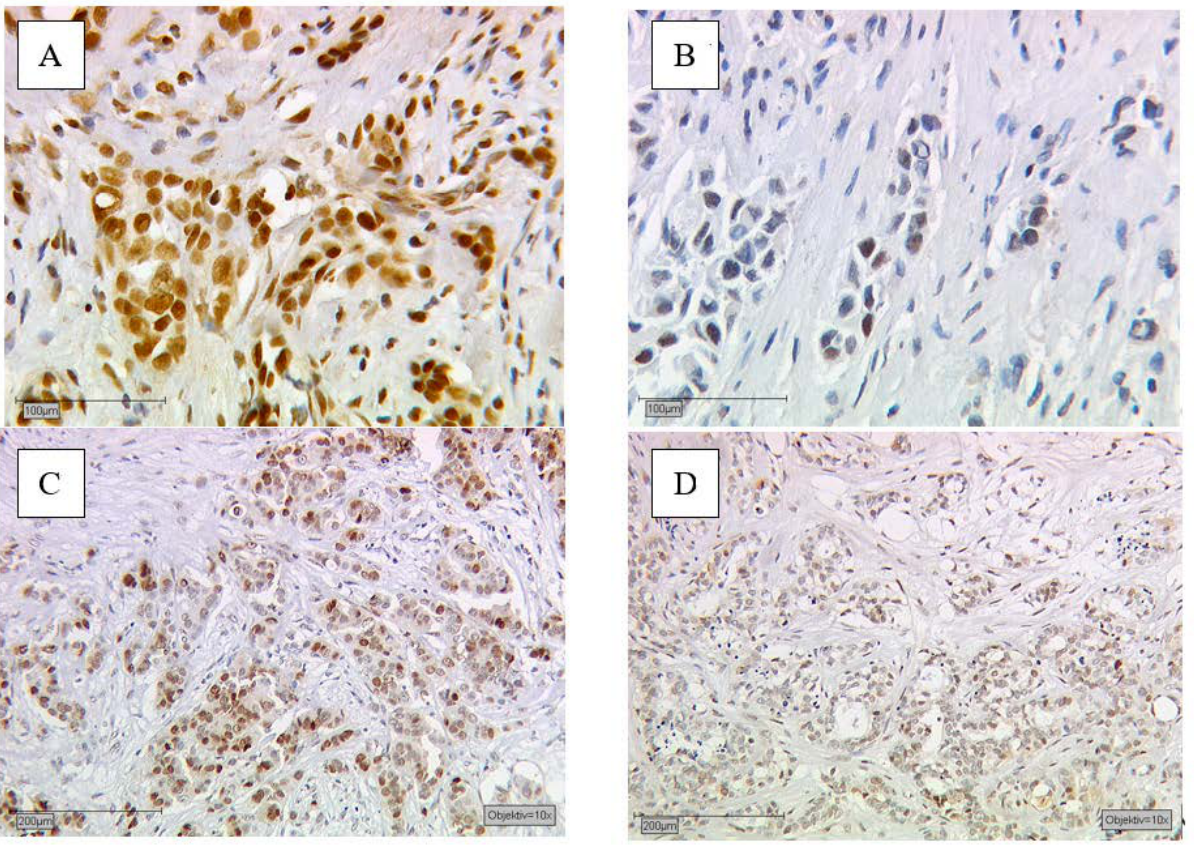
Figure 4. Shows immunohistochemical staining of RXR and THR α 2 after incubation with the primary antibody of the malignant breast cancer cells. Immunohistochemical staining of RXR in human BC ( A , B ). ( A ) With an immunoreactive score of Remmele and Stegner (IRS) of 8 meaning RXR positive and ( B ) an IRS value ≤ 2 being RXR negative. Immuno- histochemical staining of THR α 2 in BC ( C , D ). ( C ) With an IRS of 9 meaning THR α 2 positive and ( D ) an IRS value ≤ 1 being THR α 2